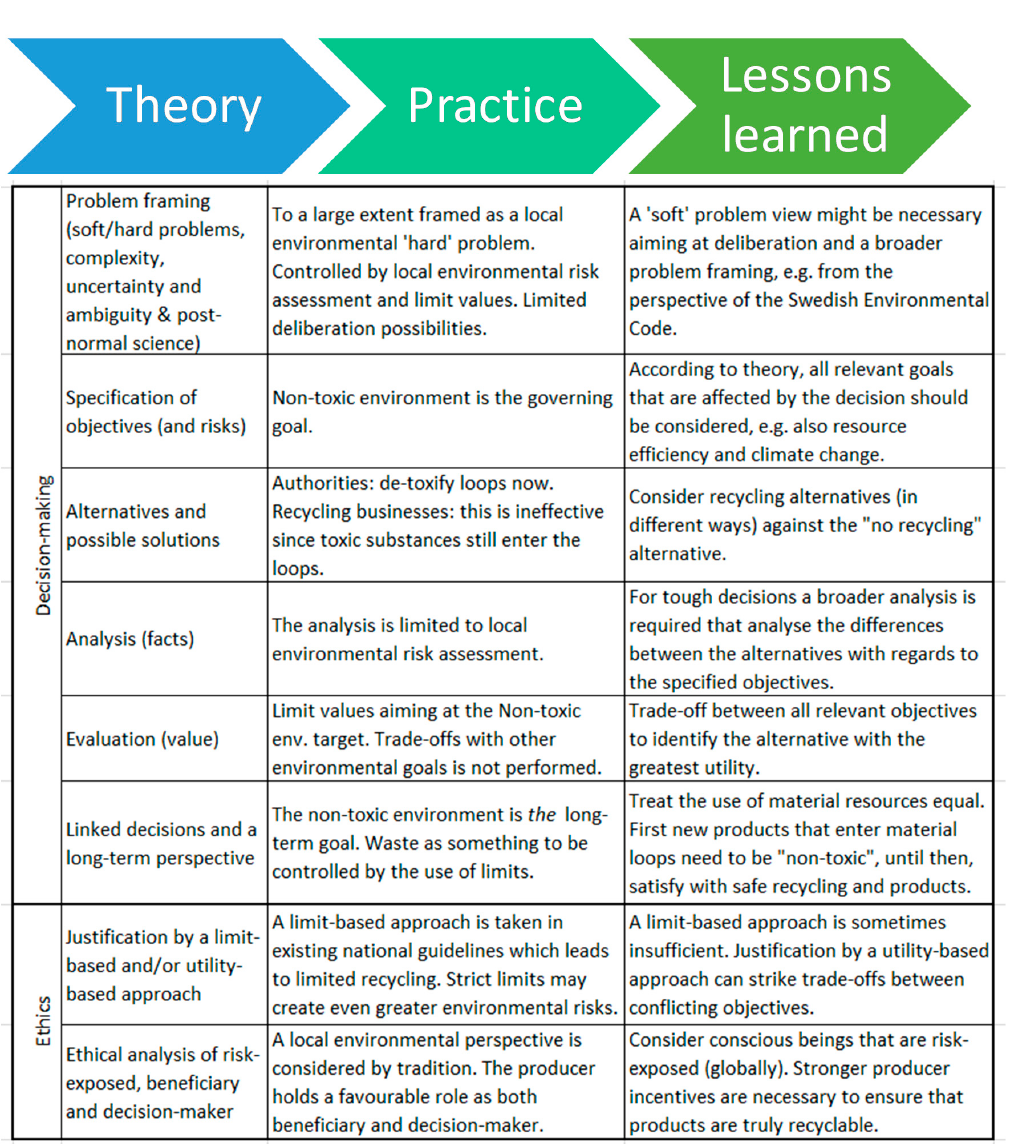
Figure 3. The factors identified in the theory section were used to analyse Swedish recycling